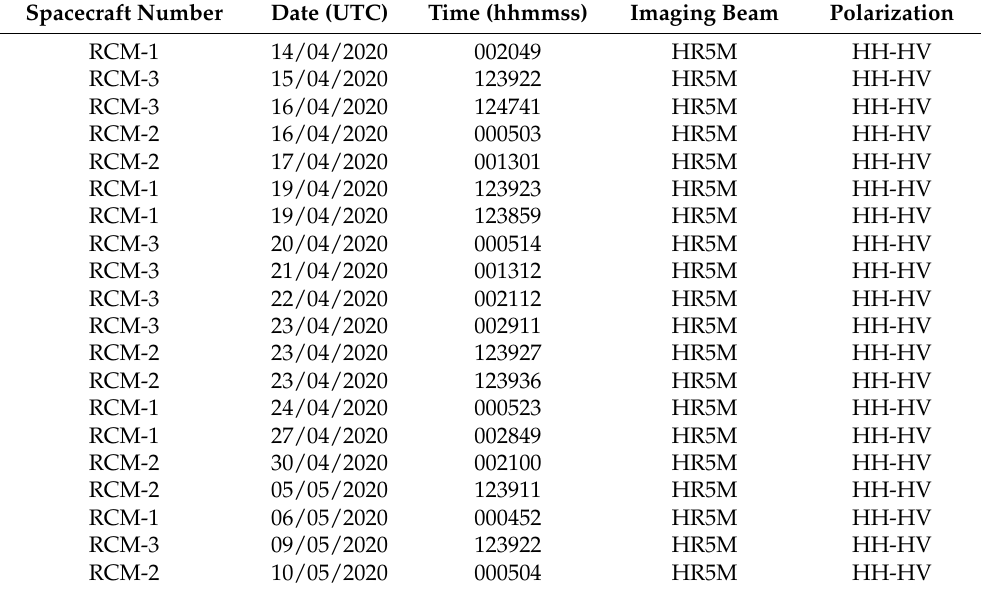
Table 2. Summary of the RCM